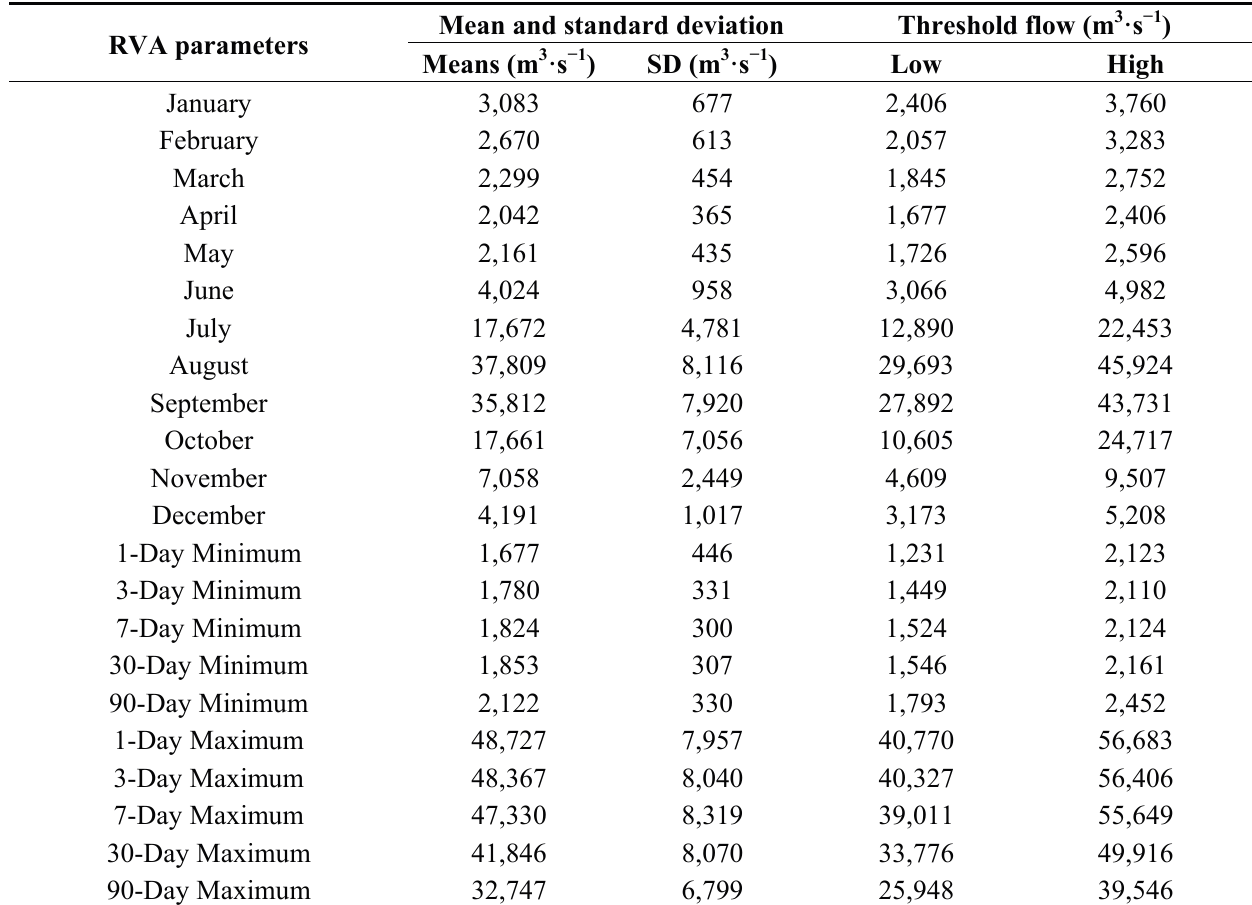
Table 2. Results of the selected Range of Variability Approach (RVA) parameter analysis (Columns 2–5) based on the data of the pre-Farakka period (1934–1974). RVA